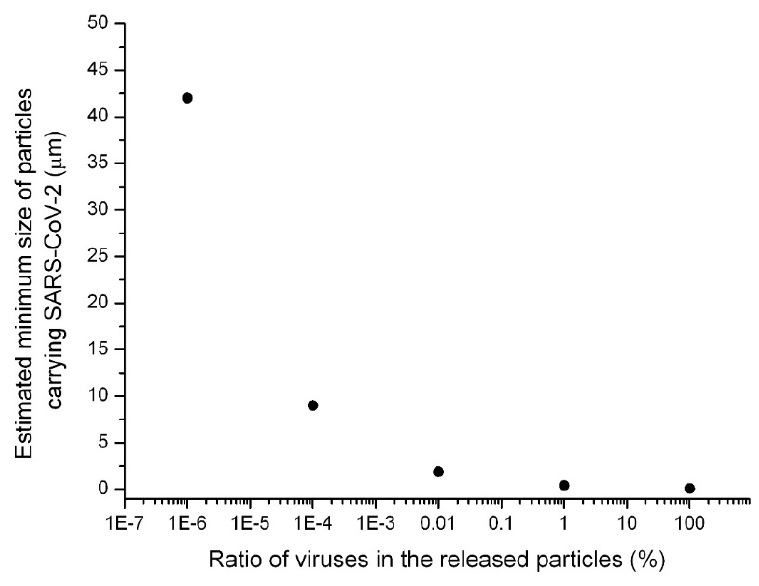
Figure 2. Estimated minimum size of particles (assuming homogenous distribution of viruses in released respiratory fluid particles and virus size of 0.09 μm) potentially carrying SARS-CoV-2.